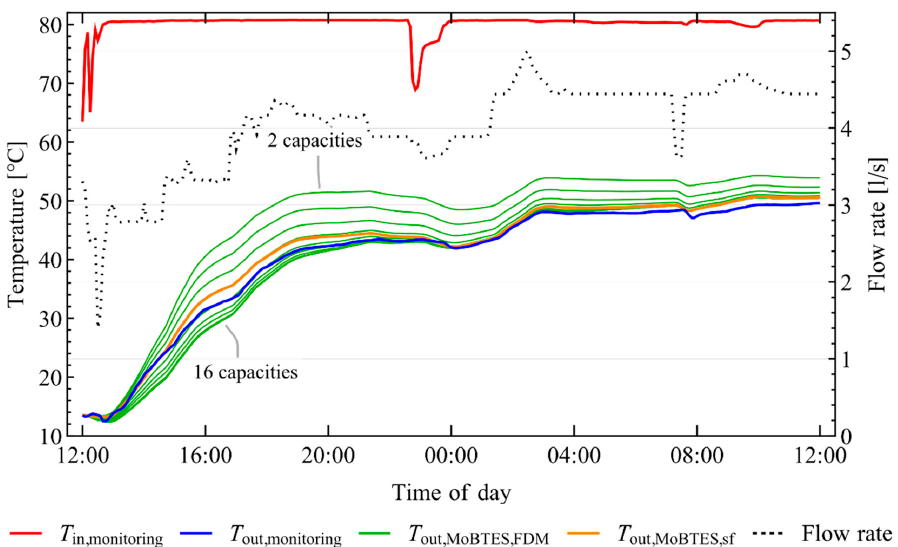
Figure 11. Comparison of monitored and simulated outlet temperatures for MoBTES models with Thermal Resistance and Capacity Model (TRCM) (FDM variants: number of capacity nodes increases from top to bottom).